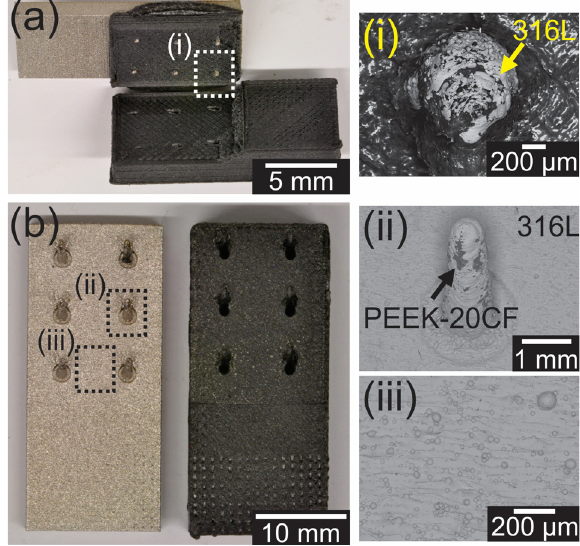
Figure 7. (a ) Horizontal and ( b ) vertical U-Joints tested under lap shear. ( i )–( iii ) show SEM analyses of selected regions on the fracture surfaces from both conditions.